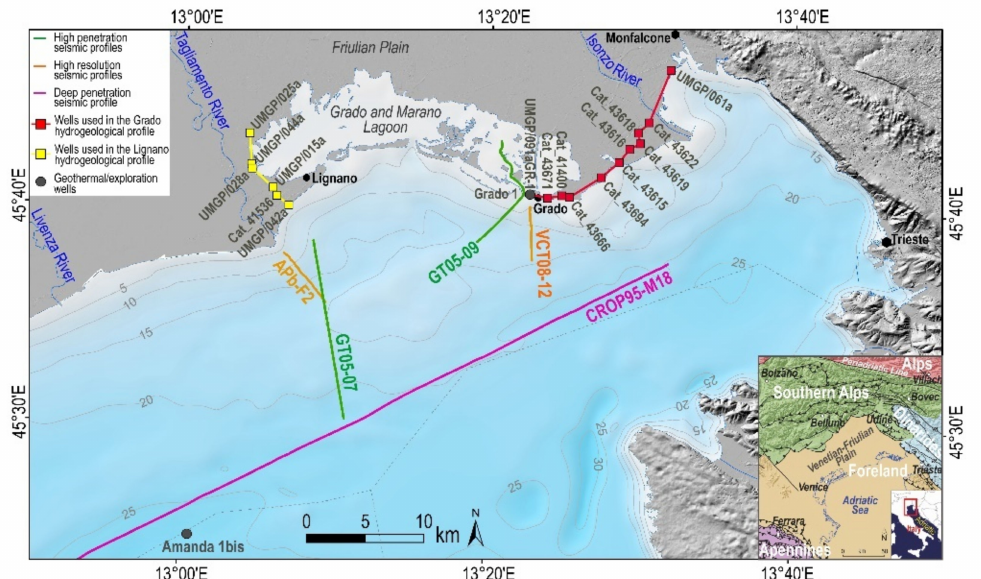
Figure 1. Location map of the study area over the Friulian Plain and the north-eastern Adriatic Sea. The analysed marine high penetration multichannel seismic reflection profiles acquired by the National Institute of Oceanography and Applied Geophysics (OGS) are represented in bold green lines, while the orange bold lines represent the OGS high-resolution seismic boomer profiles. The pink bold line shows the position of the deep crustal investigation multichannel seismic profile CROP95-M18. The positions of the Grado 1 geothermal well and of the Amanda 1bis exploration well are represented by the grey hexagons. The water wells used to construct the Lignano and Grado lithostratigraphical profiles of the aquifers are shown by yellow and red squares, respectively. Bathymetry in depth with cells of 50 m and contours every 5 m, gridding performed by [30] by using grids from Italy and Slovenia [31] and Croatia [32]. Digital Elevation Model compiled for Italy (5 and 10 m cells by [33,34], respectively), Slovenia (10 m cells; [35]) and Istria (25 m cells; [36]). The inset map shows the chains of the Alps, Apennines, Dinarides and relative foreland domain, together with the main tectonic structures [37–43]. Map compiled by using ArcGis ® (ESRI, 2017) software; datum WGS84, projection